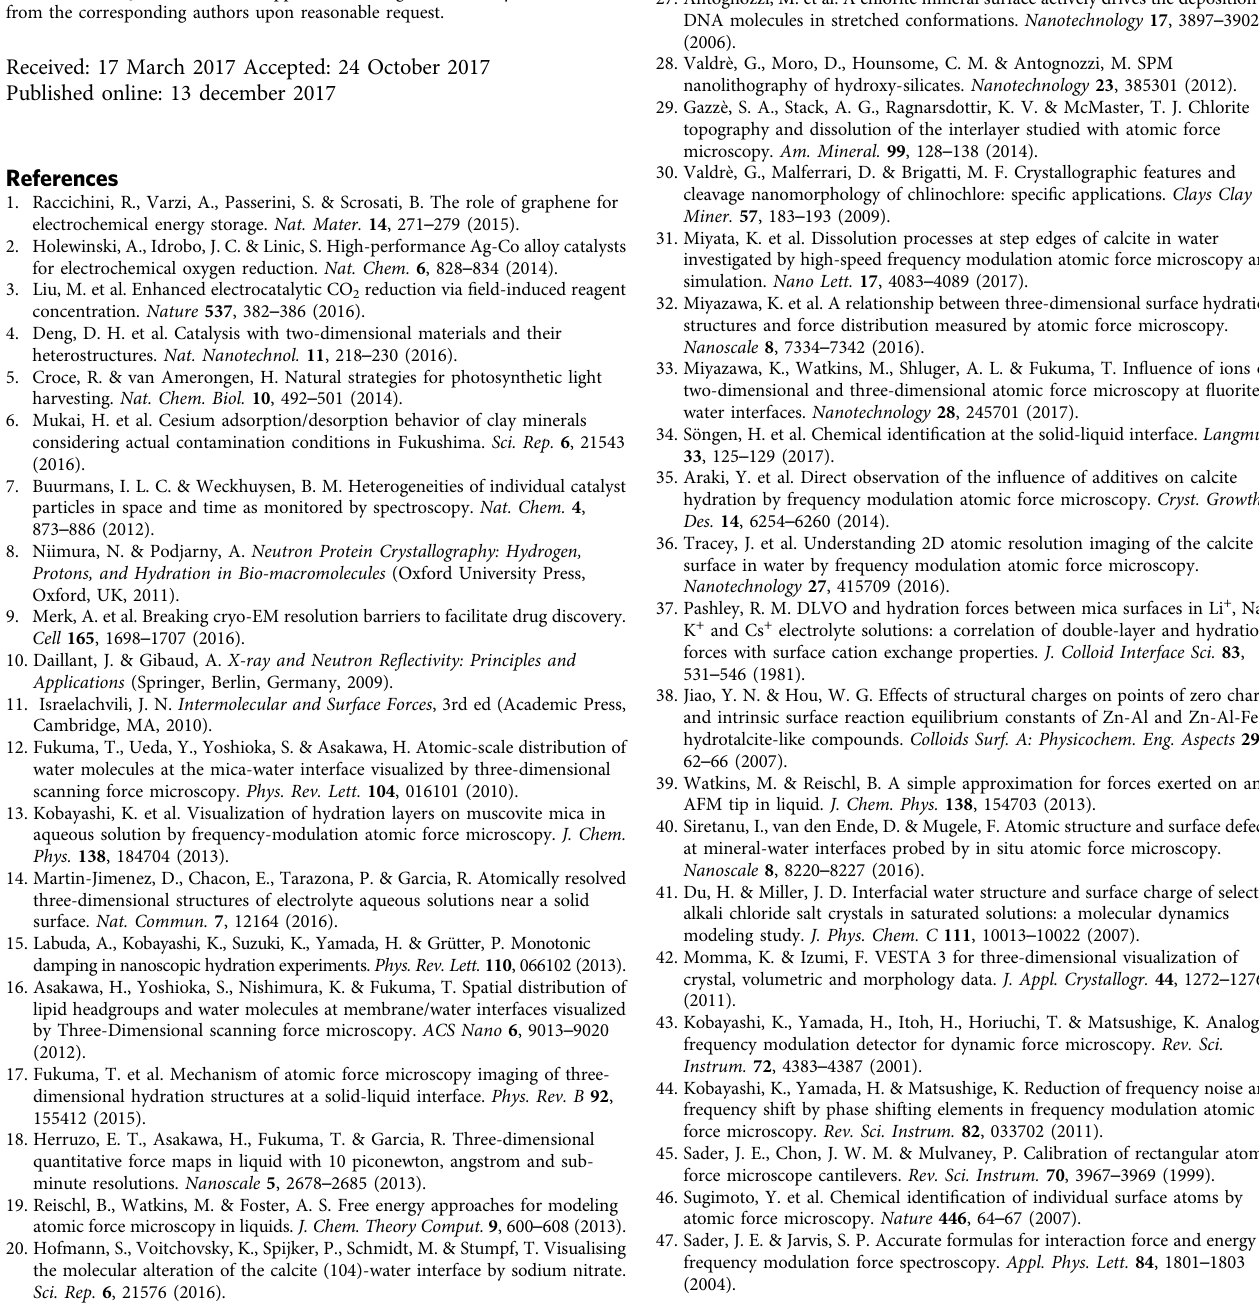
directions and a linear